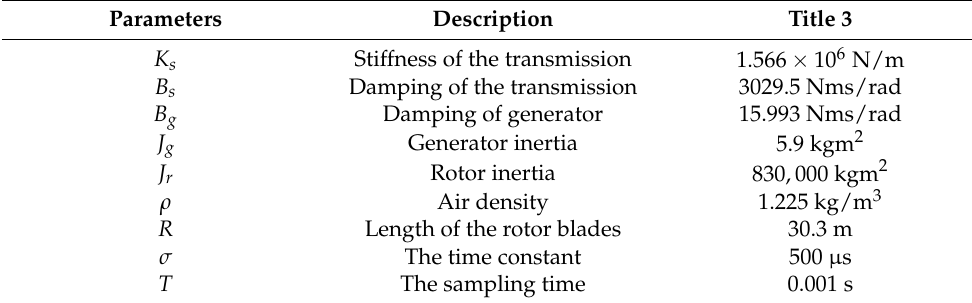
Table 1. Numerical values of a wind turbine with three blades.